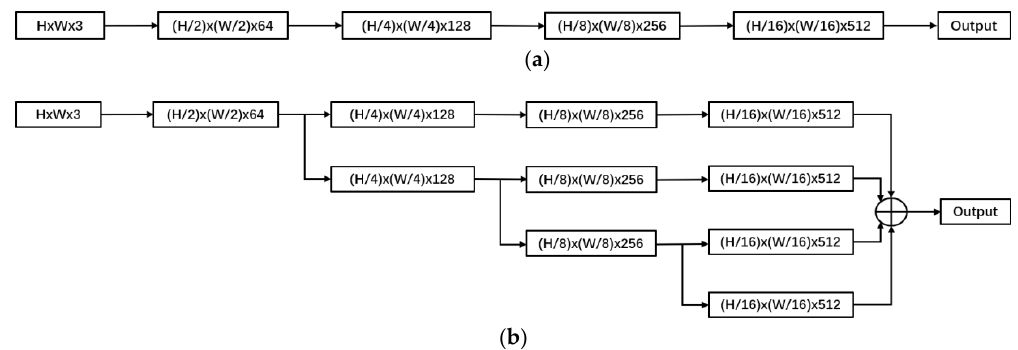
Figure 2. The size of the input image is H × W × 3, where H is the height, W is the width, and 3 is the number of channels. Here, the form of a circuit is used to represent the network structure, where ( a ) represents a neural network with a series structure, and ( b ) represents a neural network with a parallel structure.